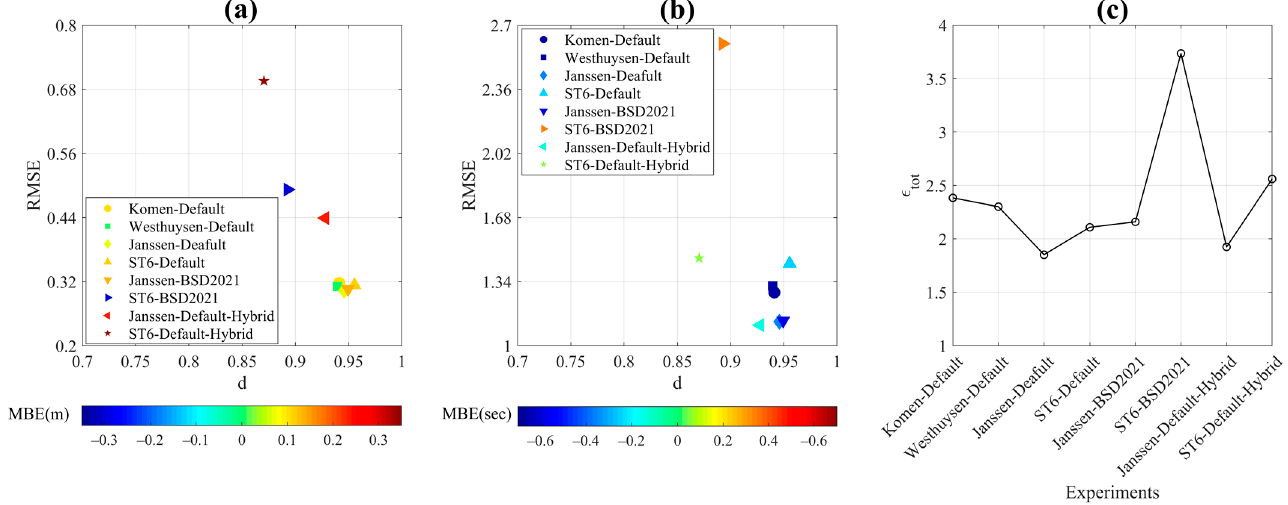
Figure 11. Estimated MBE , RMSE , and d indices for ( a ) 𝑯 𝒔 and ( b ) 𝑻 𝒛 . ( c ) Variations in 𝝐 𝒕𝒐𝒕 (Equation (10)) with different model scenarios.